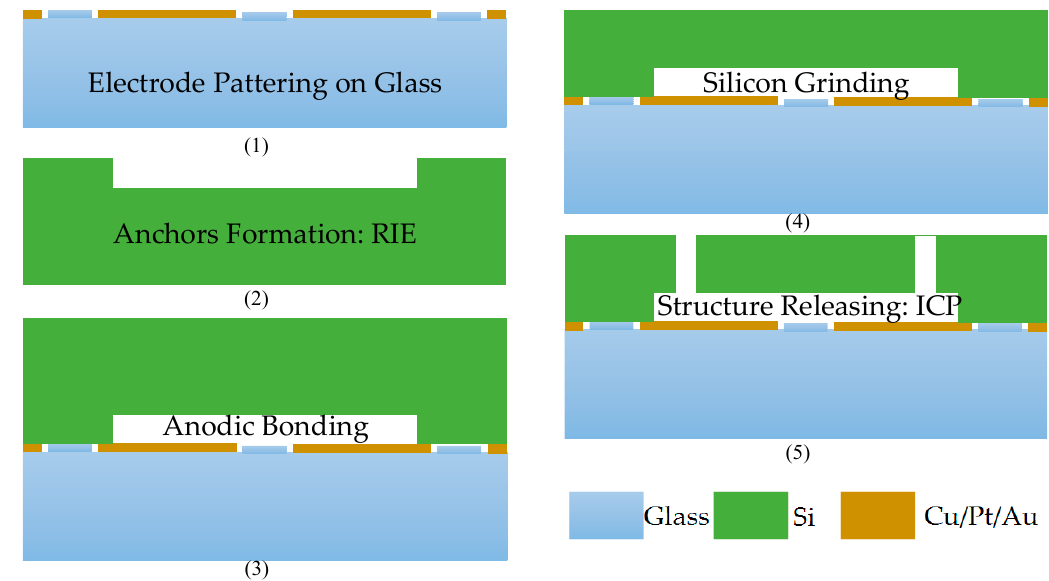
Figure 2. Fabrication process flow of the sense element.